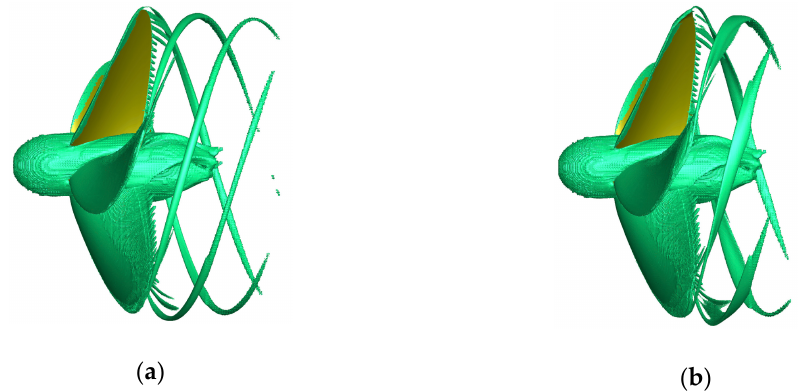
Figure 21. Iso-surface of H = − 600 m/s 2 at J = 0.7: ( a ) benchmark propeller and ( b ) winglet-propeller.